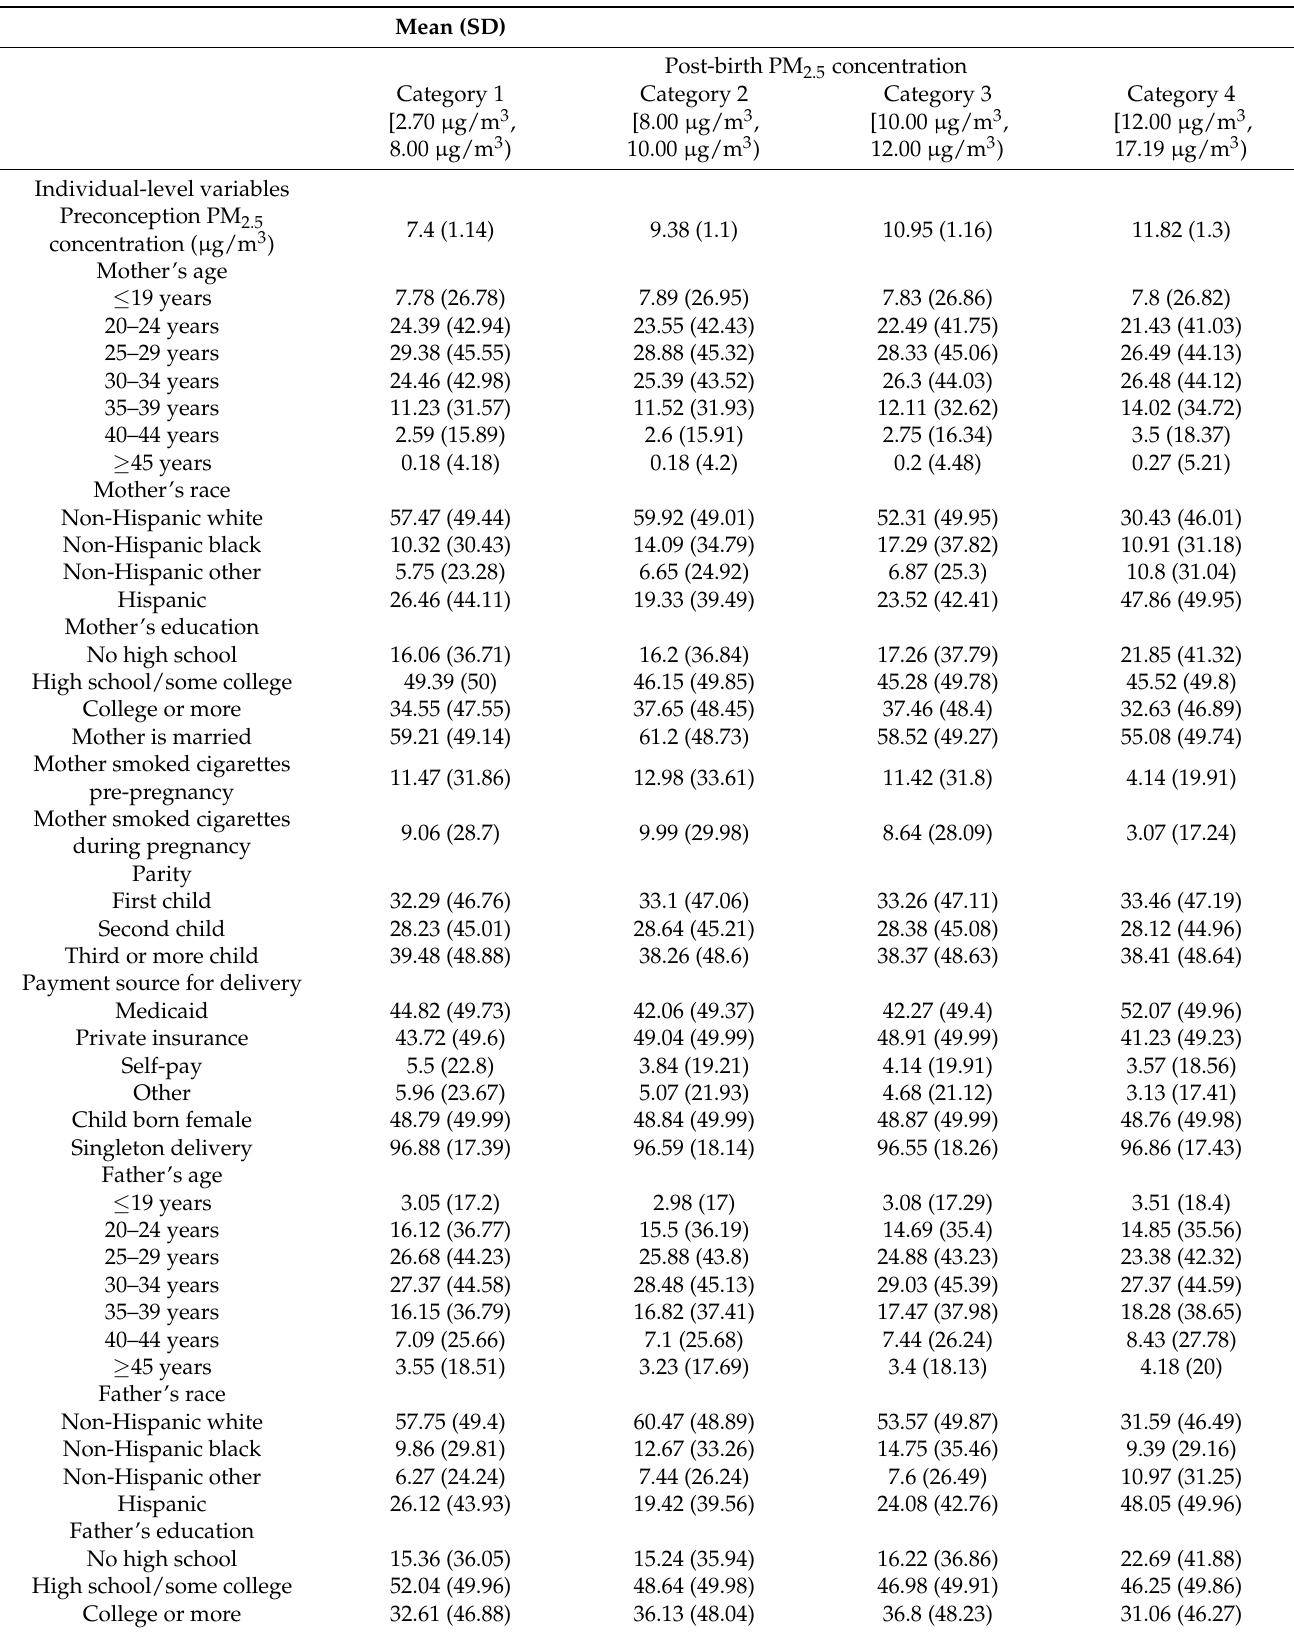
Table A5. Distribution of individual, delivery, and county-level covariates in the analytic sample by categories of post-birth PM 2.5